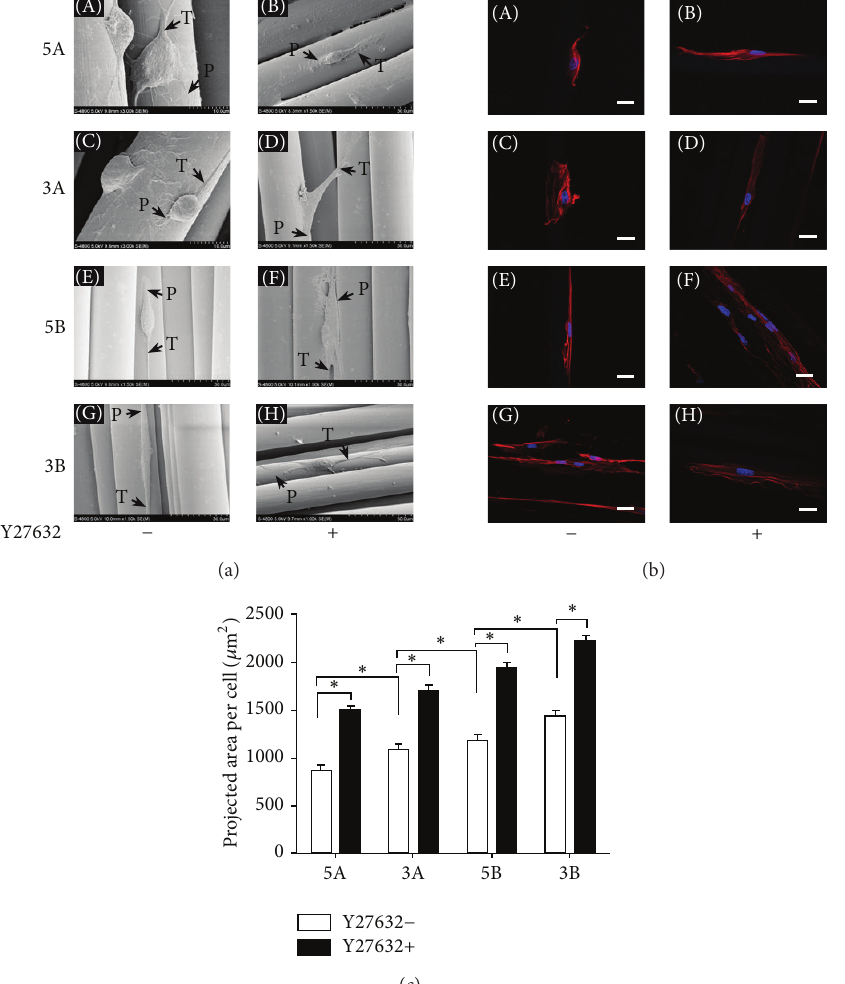
Figure 2: SEM images of BMSCs morphology in different groups after incubation for 3 days (a). Confocal laser scanning microscopy images (b) of BMSCs F-actin cytoskeletal (red, Rhodamine-phalloidin) morphology and nucleus (blue, DAPI) in different groups after 3 days of incubation. (c) Histogram of the cell projected cell area which was analyzed from the fluorescent images. P indicates cellular pseudopod, T indicates cellular tail, and ∗ indicates 𝑝 < 0.05 . Scale bars: 200 𝜇 m.